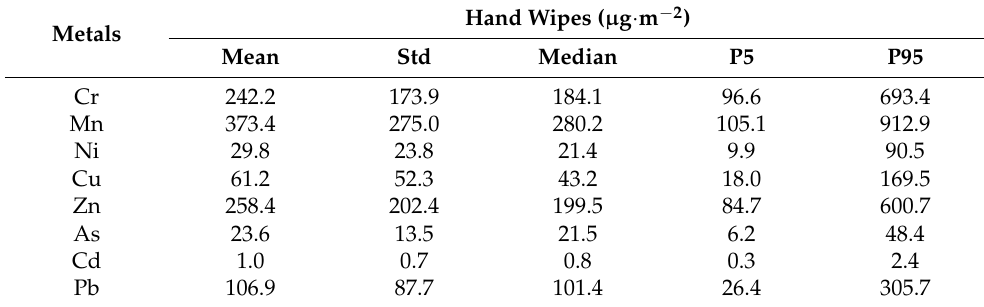
Table 1. Descriptive statistics of the amounts of metals in hand wipe samples per unit area.